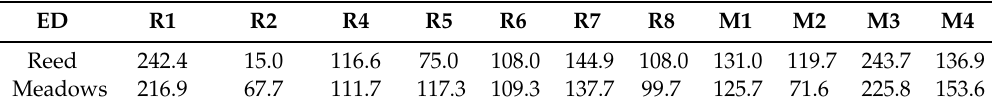
Table 7. The Euclidean distance (ED) values between the individual targets and the mean spectra of the two classes. R1–R2 and R4–R8 represent reed bed targets and M1–M4 represents meadow targets.